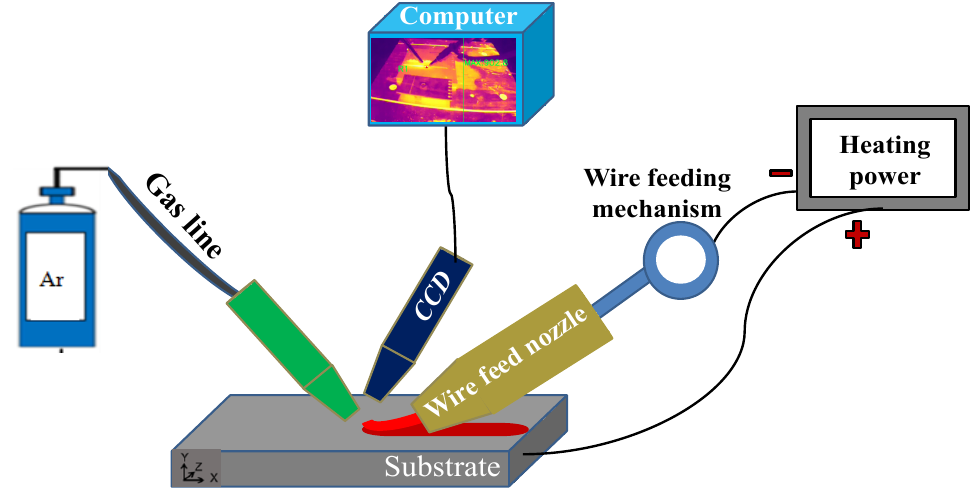
Figure 1. Forming schematic diagram of RAM.